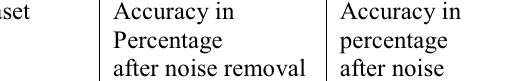
Figure 7: Statlog (Heart)-Iteration vs.